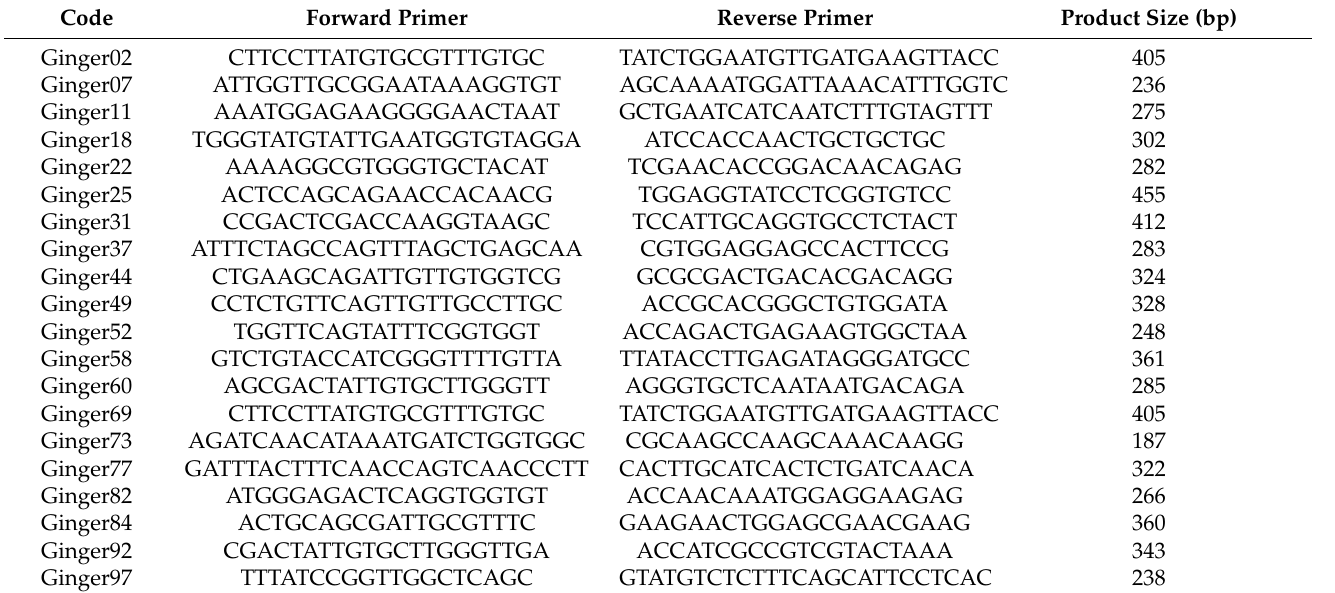
Table 1. Code and sequence of 20 pairs of SSR primers used in this